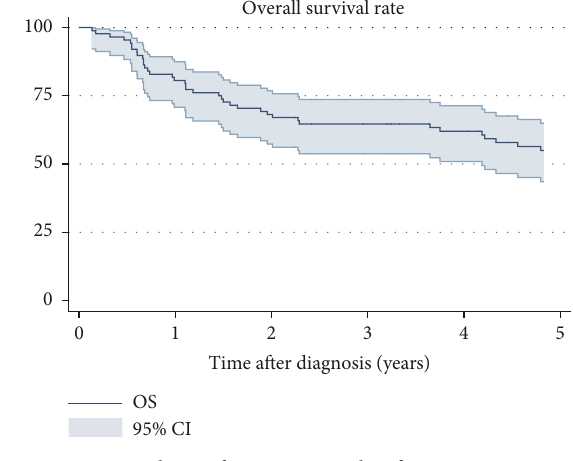
Figure 2: Survival rate of 88 patients with soft tissue sarcoma in the thoracic wall. 95% confidence intervals.